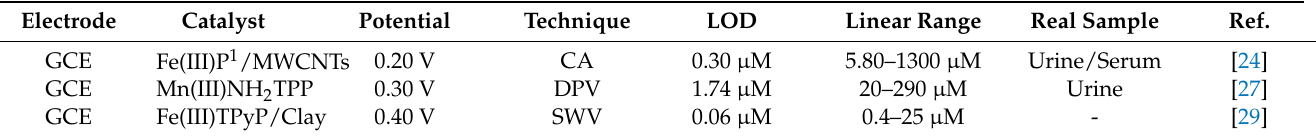
Table 2. Examples of porphyrin complexes used in the modification of electrodes for detection of uric